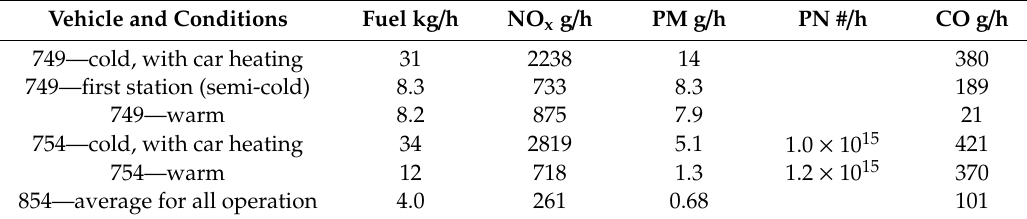
Table 2. Fuel consumption and emissions during idling.